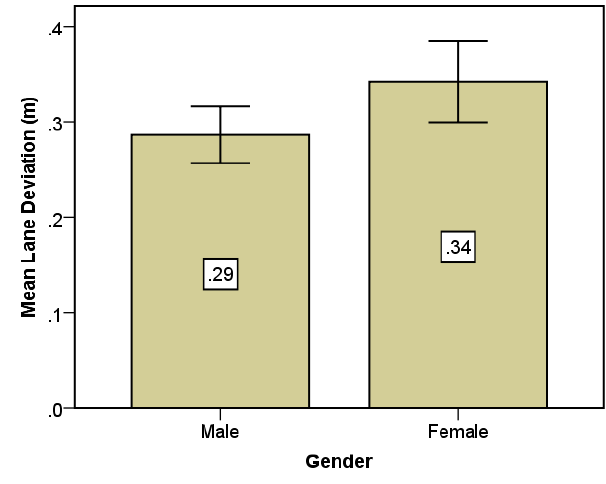
Figure 8. Mean lane deviation comparison between males and